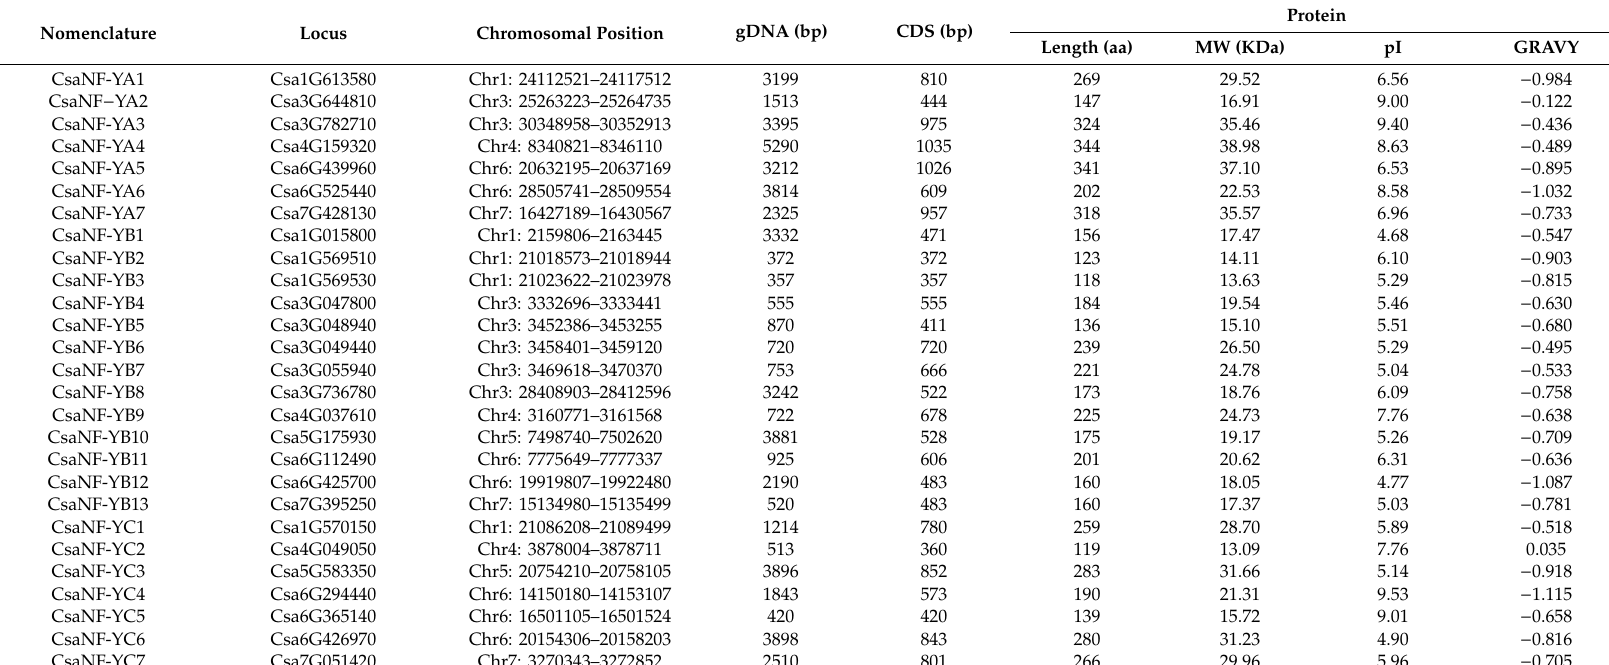
Table 1. Identification and characterization of nuclear factor Y ( NF-Y ) family genes in